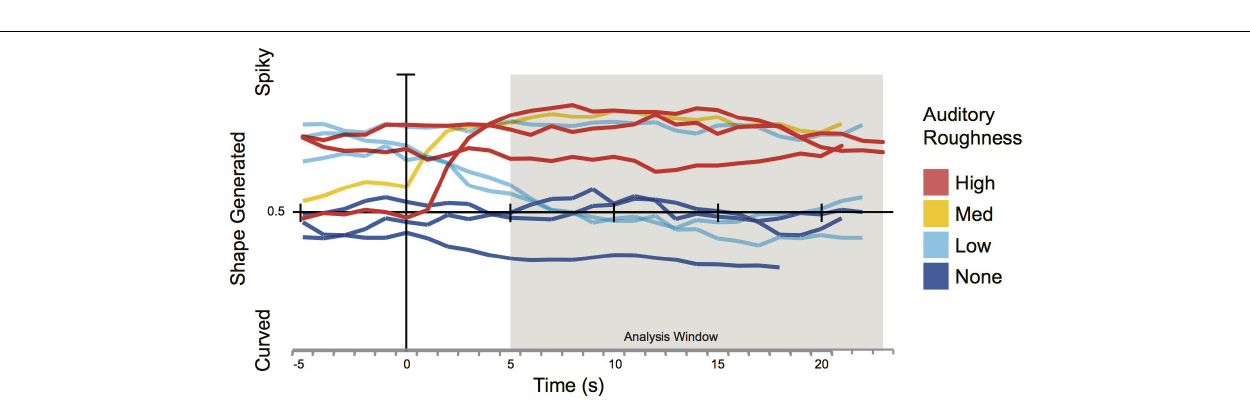
FIGURE 6 | Time-aligned average responses to each block of noise in Experiment 2 with Roughness type shown. 0 s indicates onset of noise block. Analysis window was from 5 s to end of noise